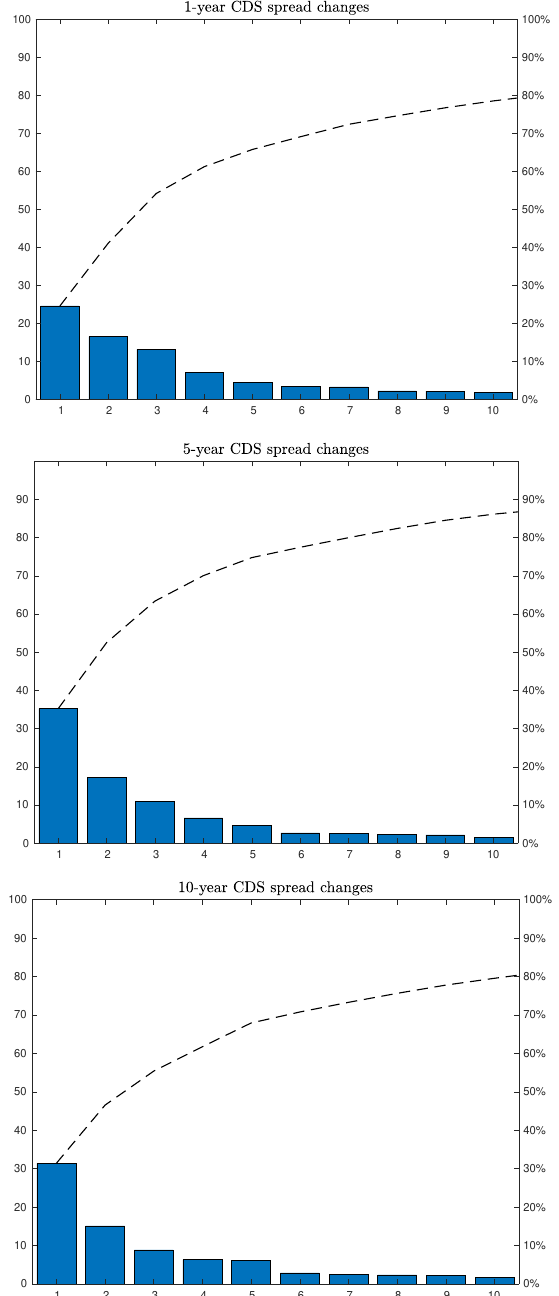
Figure 4. Scree plots for the first 10 PCs of the demeaned 1-, 5-, and 10-year CDS spread changes. The spread changes for different maturities have similar principal components and display the kink around the 3rd/4th component. Overall, the first component explains 25–35% of the total variance of the spread changes; the second component explains around 15%; the third component explains around 10%; the fourth component explains less then 10%. The first 10 PCs are able to explain 80% of the total variance for 1- and 10-year spread changes, and almost 90% of the total variance for the 5-year spread changes. However, the first four are able to explain only about 60% of the total